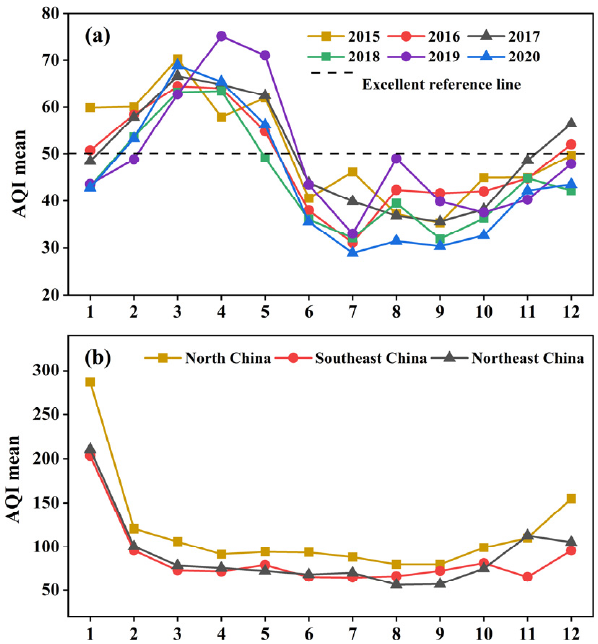
Figure 4. Monthly AQI variation characteristics ( a ) in Yunnan and ( b ) other regions of China from 2015 to 2020.